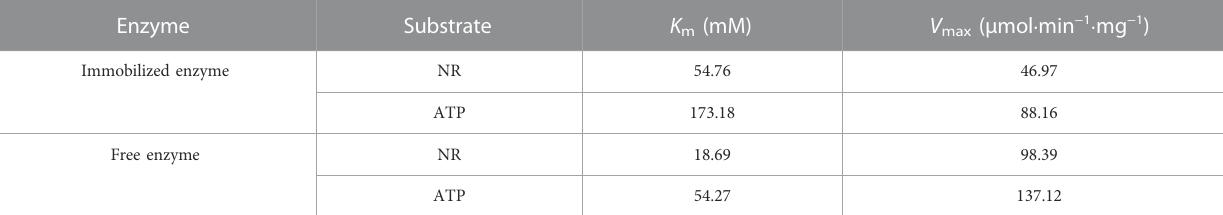
TABLE 1 Kinetic parameters of recombinant nicotinamide nucleoside kinase1.